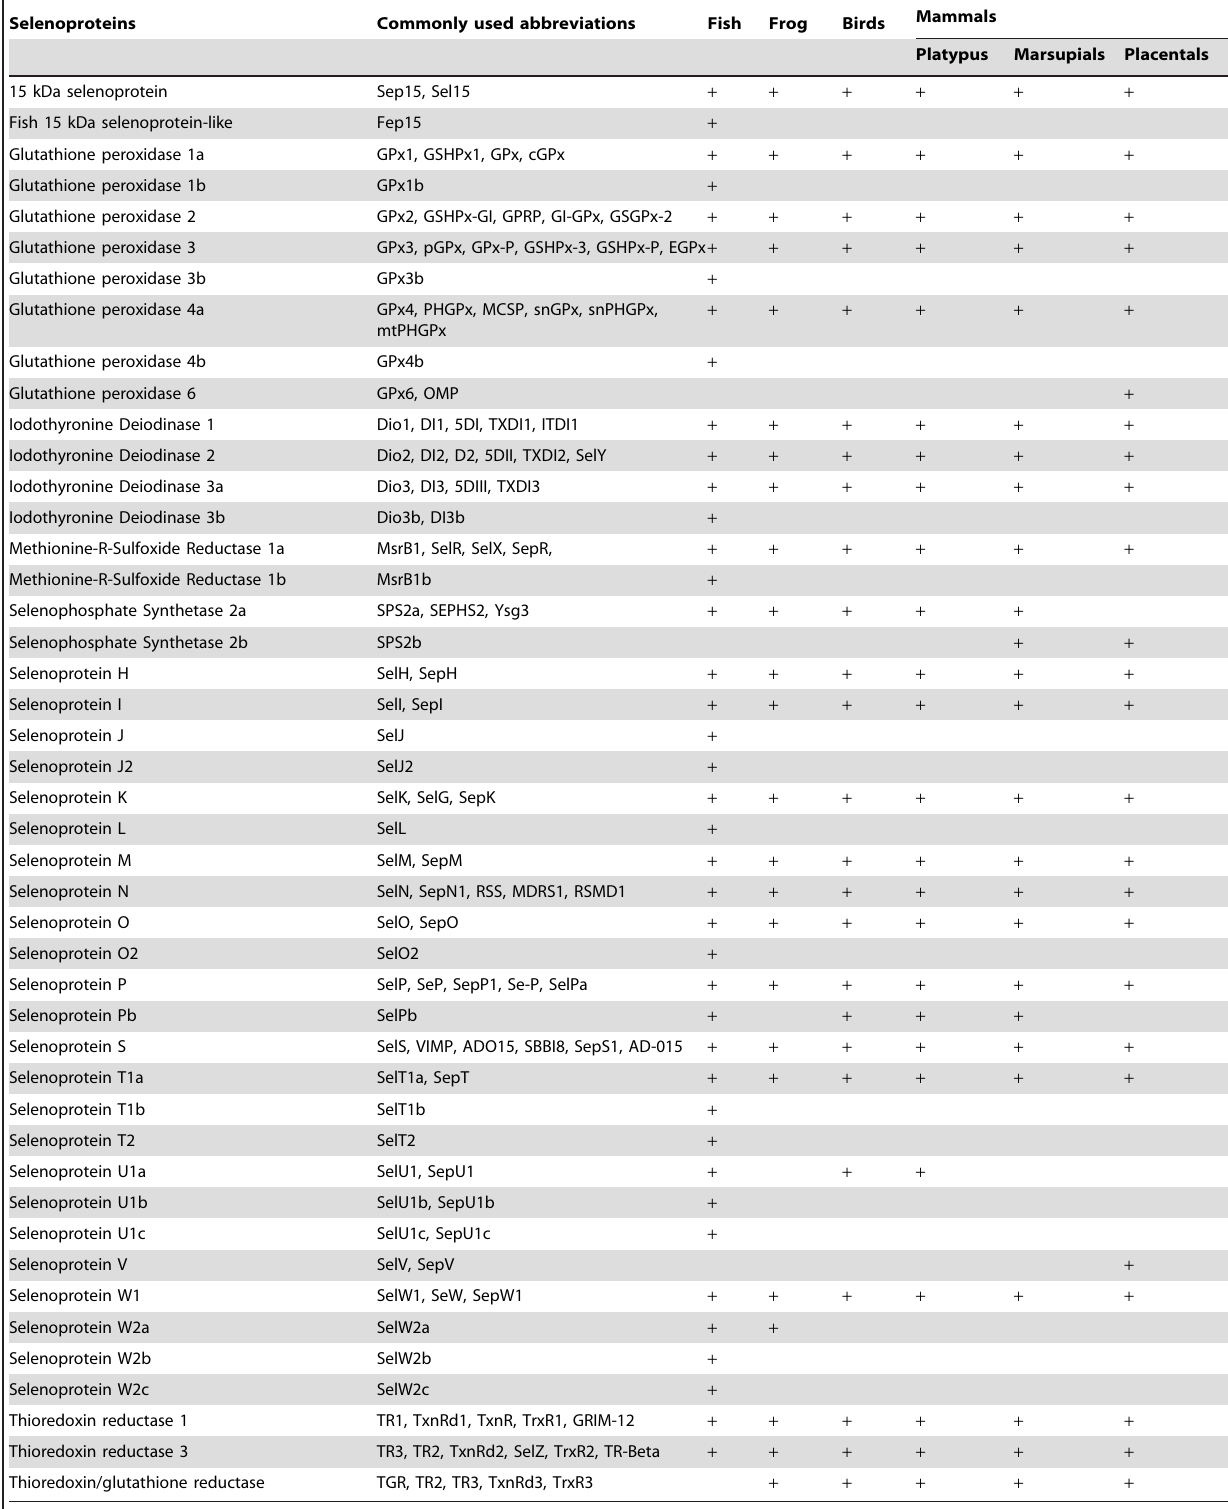
Table 1. Vertebrate Selenoproteins.